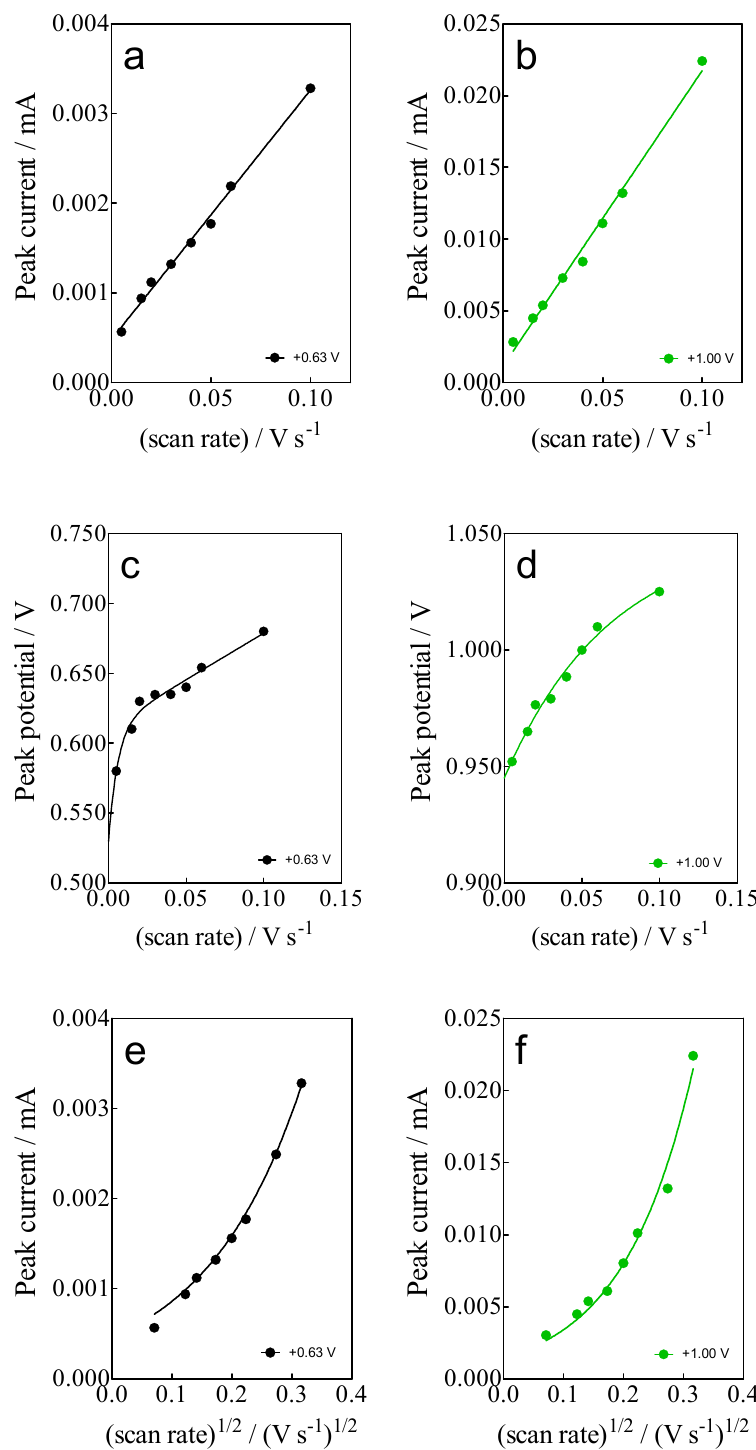
Figure 4. ( a , b ) Linear dependence of peak current ( i p ) at +0.63 V (E pa 1) and (+1.00 V (E pa 2) with the potential scan rate (V s − 1 ); ( c , d ) Non-linear dependence of E pa 1 (+0.63 V) and E pa 2 (+1.00 V) on the ν (V s − 1 ); and ( e , f ) relationship between the i p , for E pa 1 (+0.63 V) and E pa 2 (+1.00 V), and the square root of the scan rate ( ν 1/2 ). All plots were obtained for the Calcon dye (100 mg L − 1 ) in 0.25 M H 2 SO 4 at the BDD electrode.